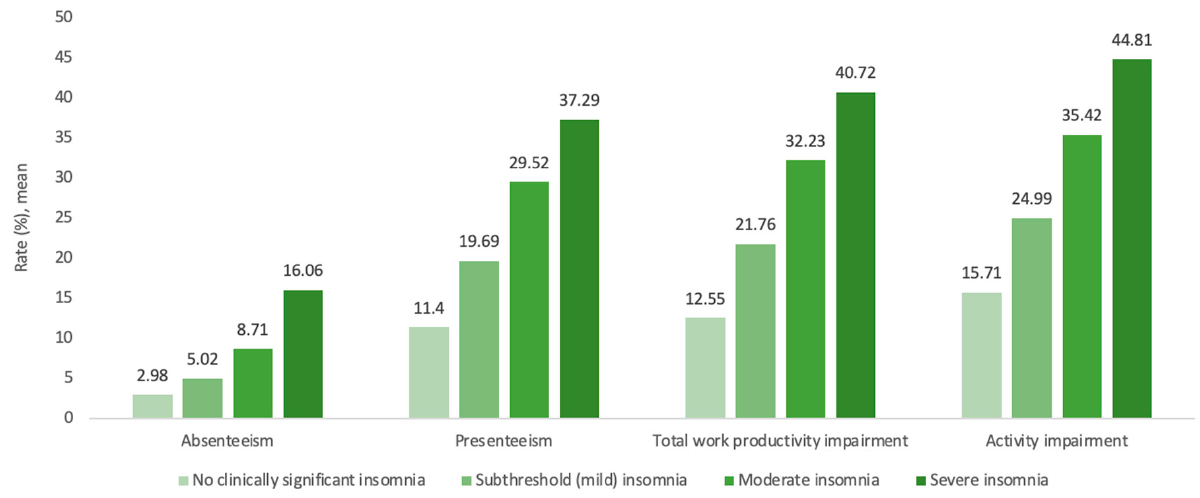
Figure 2. Association between work productivity and activity impairment values by insomnia severity category.